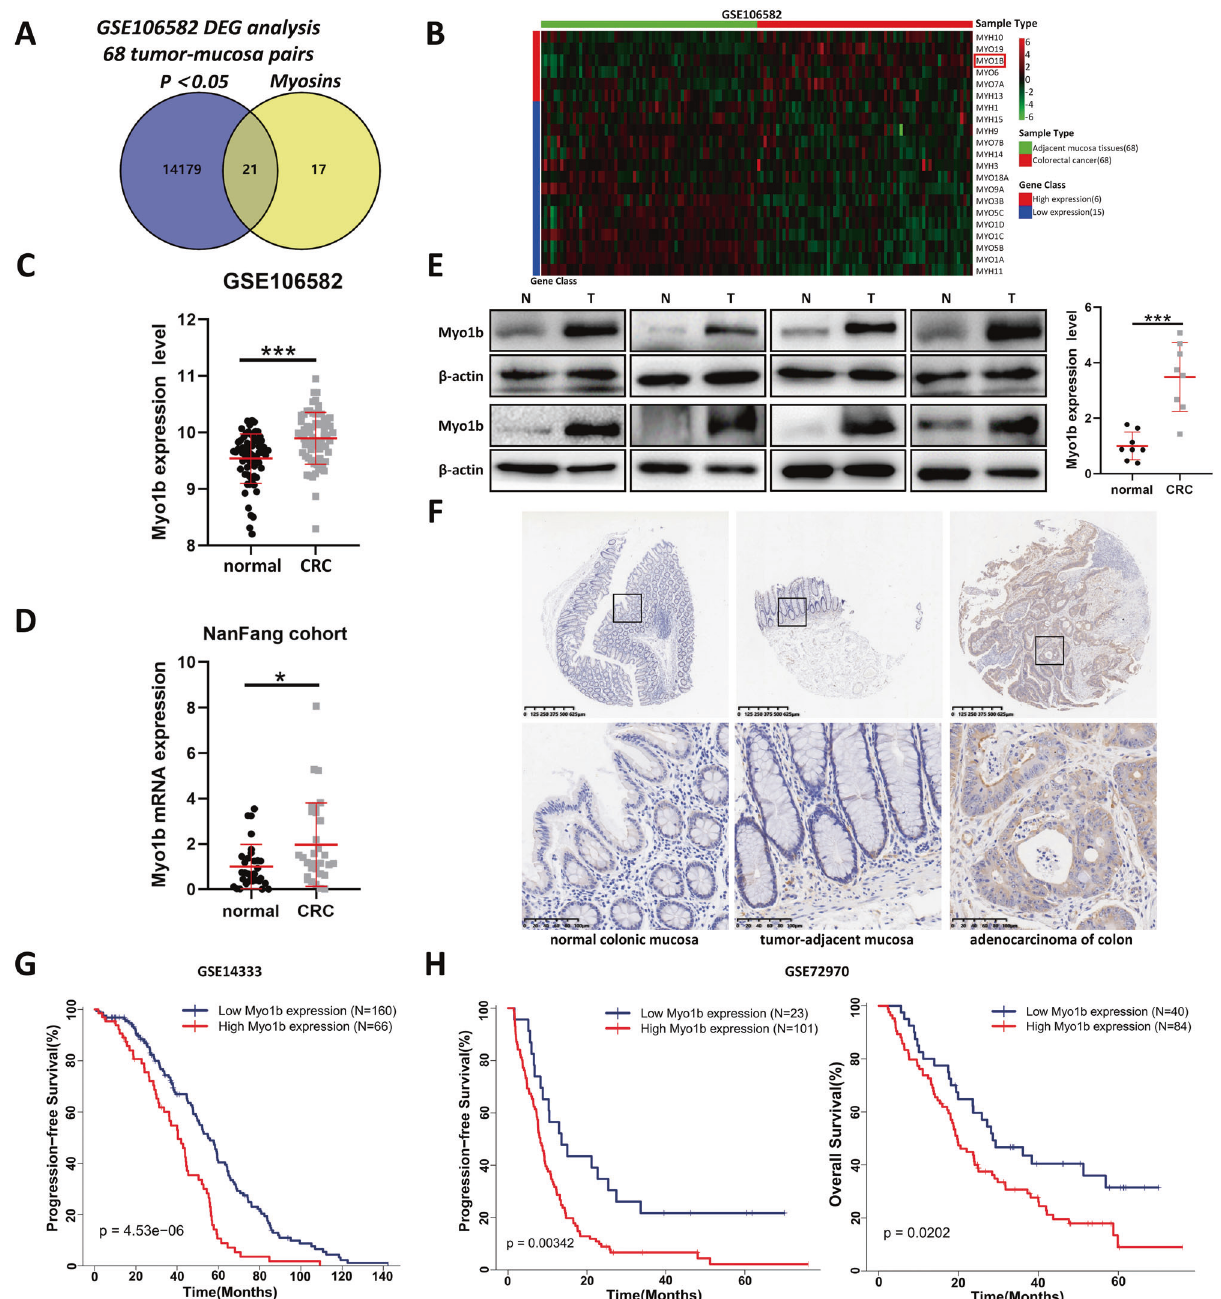
Fig. 1 Myo1b is upregulated in colorectal cancer and associated with poor prognosis. A Venn diagram depicting the overlap of differential expressed genes (DEGs) between 68 pairs CRC with adjacent mucosa tissues in the GEO dataset (GSE1065862) and myosin family genes. B Heatmap enumerates the differential expressed genes encoding Myosins between adjacent mucosa tissues and colorectal cancer samples in the GEO dataset (GSE106582). C Scatter diagram represents quanti fi cation analysis of Myo1b expression in adjacent mucosa tissues ( n = 68) and colorectal cancer ( n = 68) from the GEO dataset (GSE106582). D Scatter diagram represents Myo1b mRNA expression level of adjacent mucosa tissues ( n = 31) and colorectal cancer tissues ( n = 31) from Nanfang Hospital. The data are normalized to GAPDH. E Western blot was conducted to examine the protein levels of Myo1b in 8 cases of CRC tumor (T) and matched adjacent mucosa (N) tissues. The scatter diagram (right) shows the relative expression of Myo1b in human CRC tumors and matched adjacent mucosa tissues (normalized to β -actin). F Representative immunohistochemical staining of Myo1b protein in normal colonic mucosae, colon adenocarcinoma and paired adjacent mucosa with different staining intensities. G, H Survival curves for CRC patients with low Myo1b expression versus high Myo1b expression through analyzing data from GEO datasets (GSE14333 and GSE72970), and the optimal cut-off value of Myo1b expression was determined by Youden ’ s index. Each bar represented the mean ± SD ( n ≥ 3). * p < 0.05, *** p < 0.001.